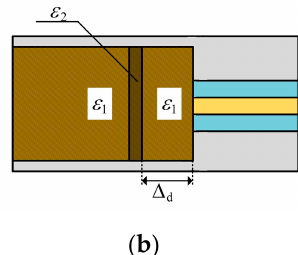
Figure 22. The simulation model for verification the effect of complex permittivity changes in different regions on the reflection coefficient: ( a ), with the isolation layer; ( b ), without the isolation layer.